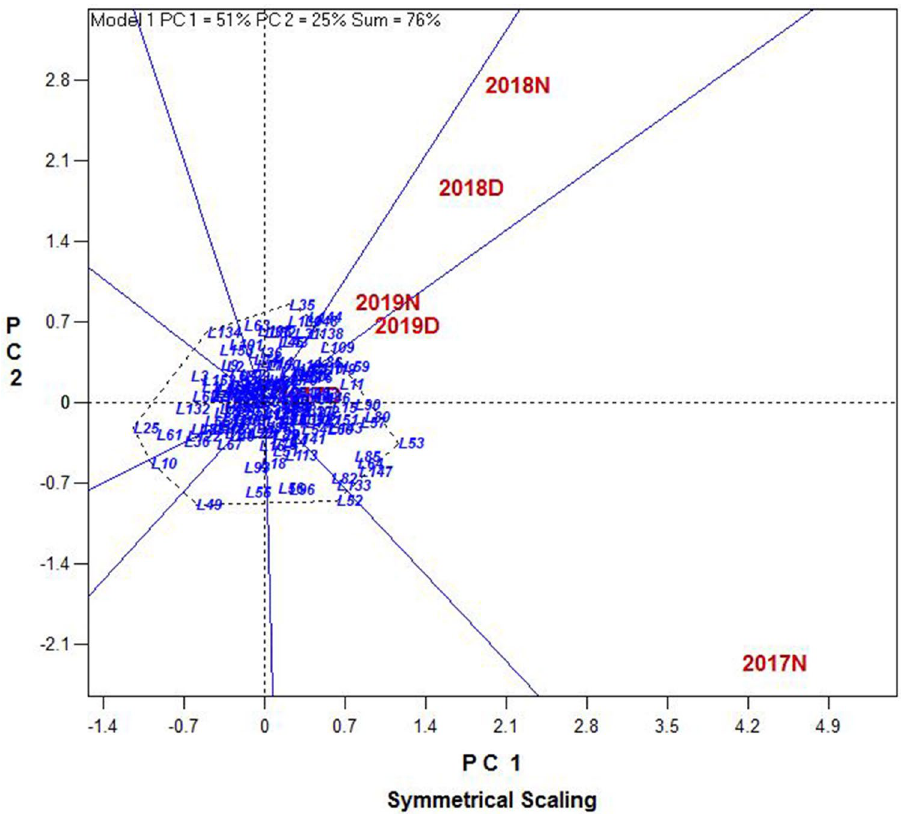
Figure 6. Polygon view of the GGE biplot rice RILs showing which line yielded best in each of six environments including non-stress (N) and drought stress (D) for 2017 to 2019.